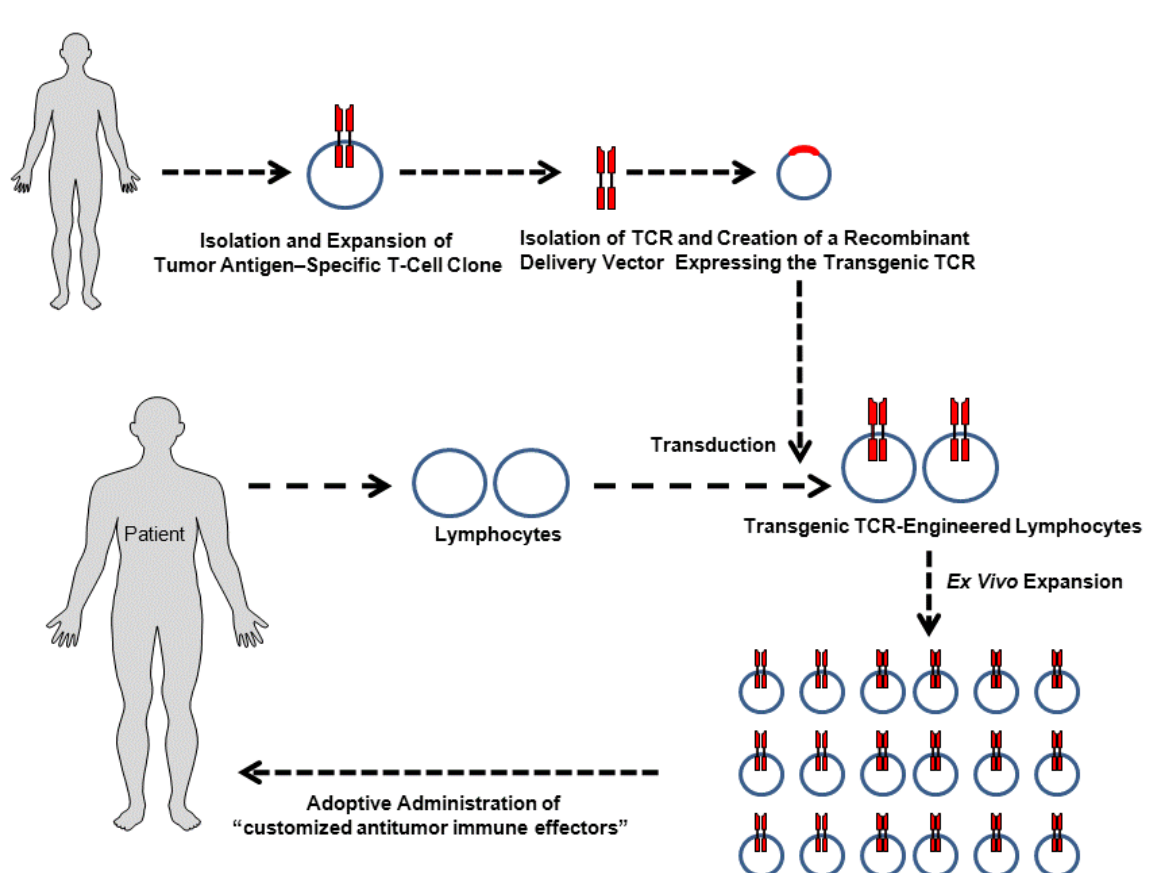
FIGURE 2. Schematic representation of the TCR engineering–based adoptive cancer immunotherapy